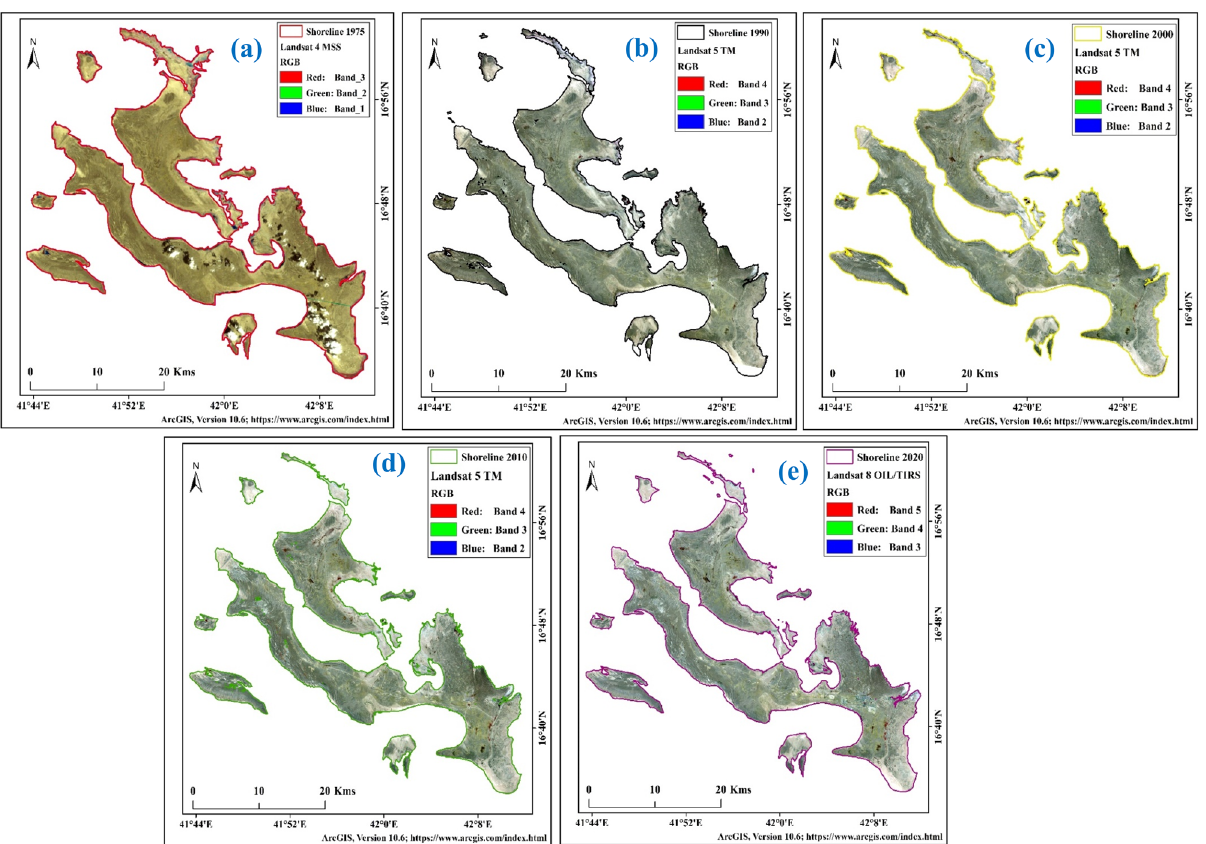
Figure 8. Shoreline of Farasan Islands in different years; ( a ) 1975; ( b ) 1990; ( c ) 2000; ( d ) 2010; and ( e ) 2020 31,64 . The satellite data was downloaded from USGS earth explorer (https:// earth explo rer. usgs. gov/). The map was generated using ArcGIS software, version 10.6 (https:// suppo rt. esri. com/ zh- cn/ produ cts/ deskt op/ arcgis- deskt op/ arcmap/